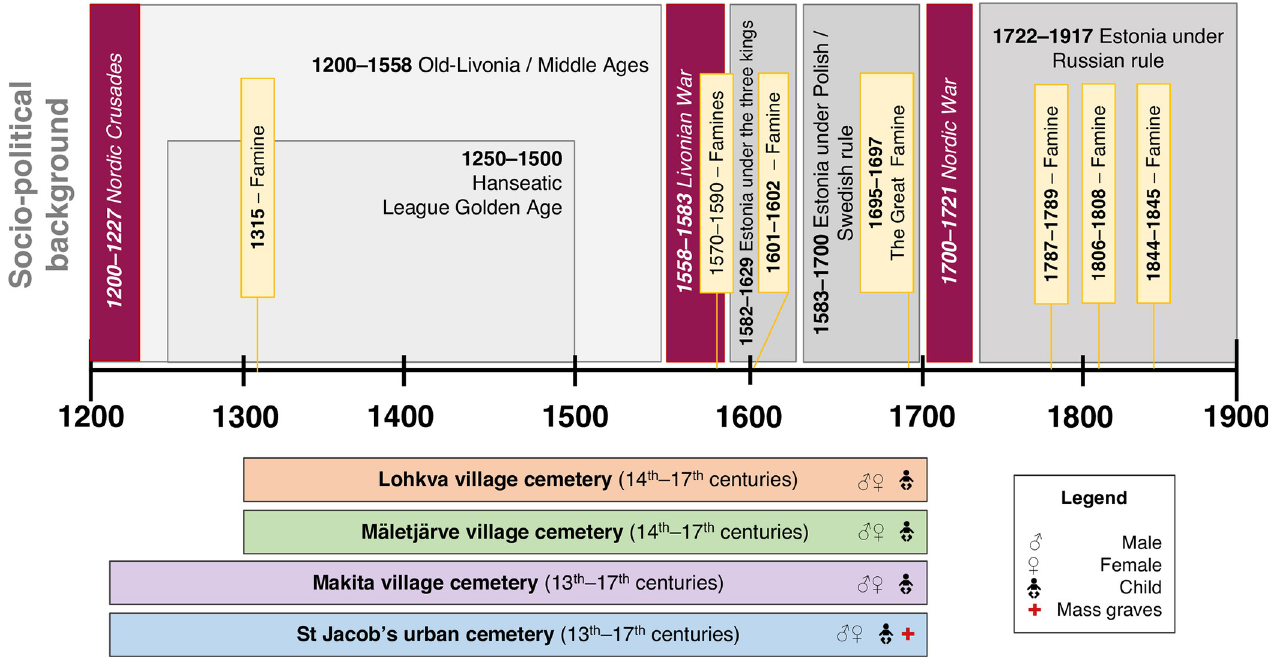
Fig 1. Historical context of this study. Major socio-political events and the corresponding timeframes of burials in the analyzed cemeteries.